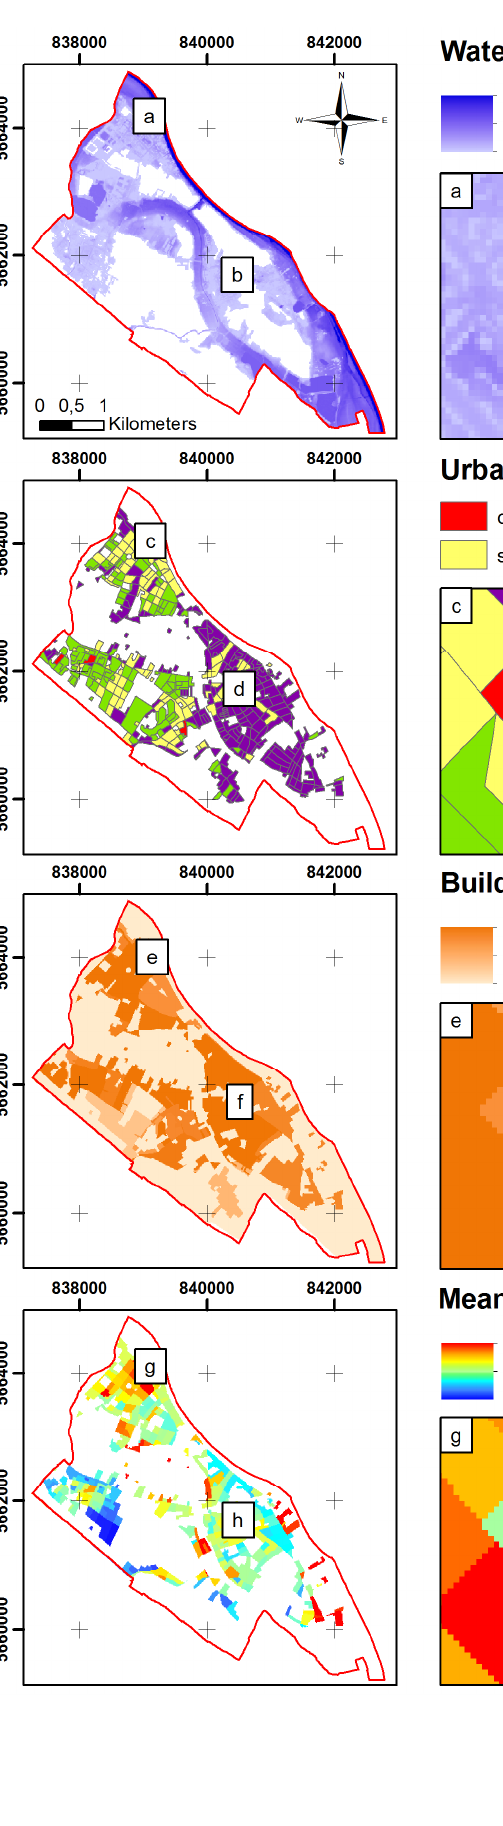
Figure 7. Water depth, urban structure types, building values, and resulting distribution of losses in Leuben (projection: WGS 84—UTM Zone